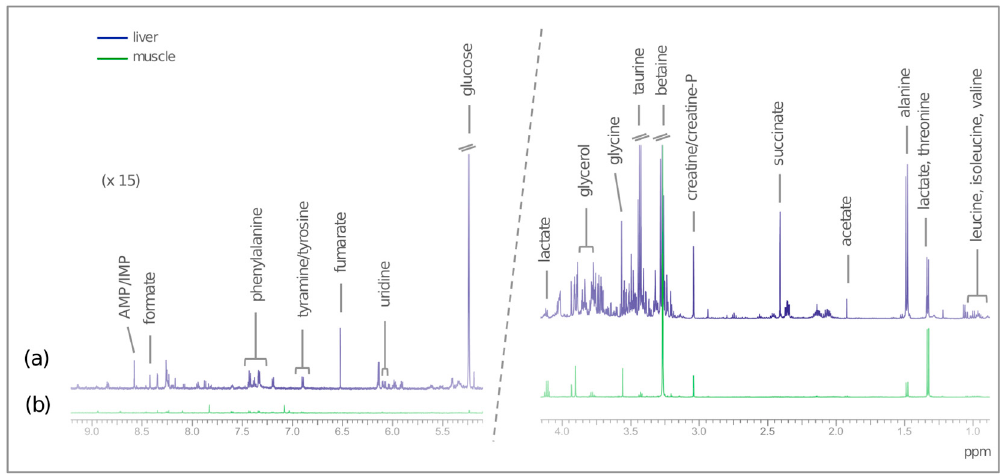
Figure 4. Representative NMR spectra from European seabass: ( a ) CPMG spectrum of the aqueous fraction of liver, and ( b ) 1D 1 H spectrum of the aqueous fraction of muscle, with the assignments of the main identified